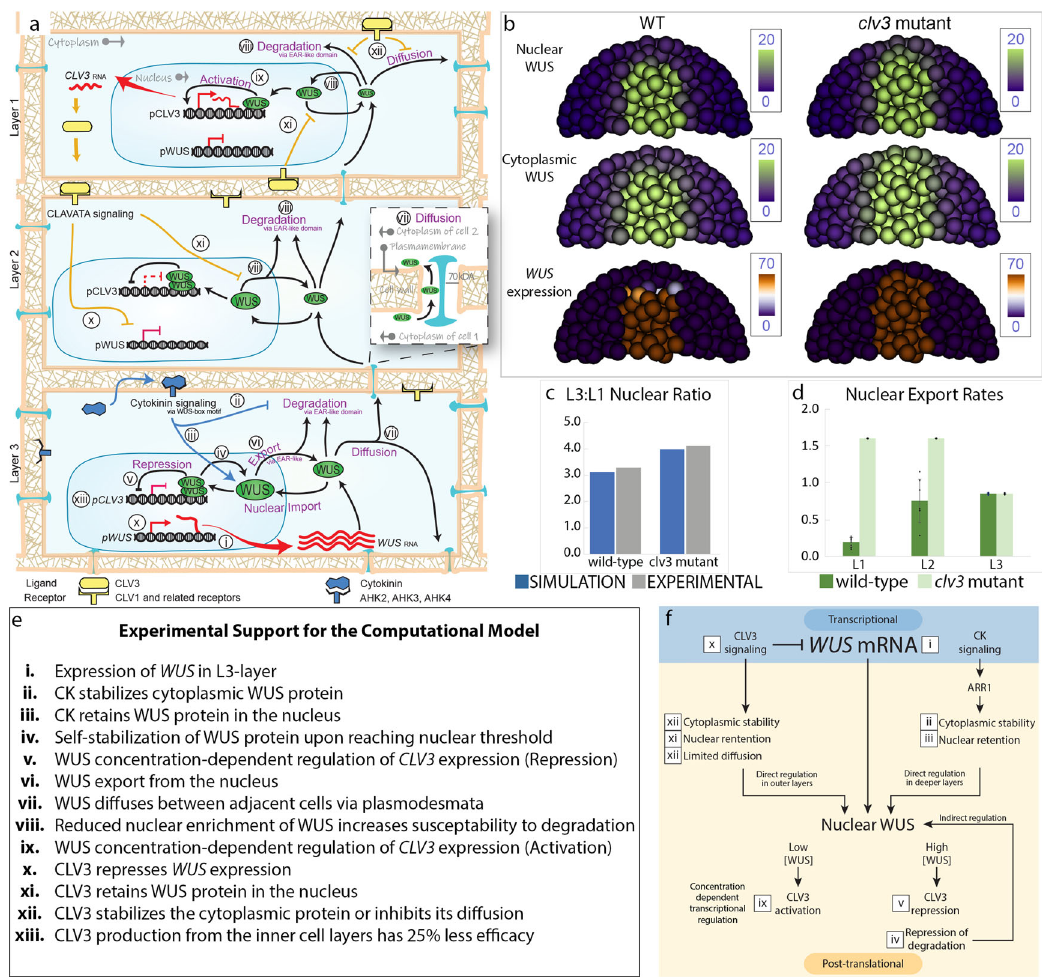
Fig. 5 Multi-cell layer model for the regulation of the WUS protein gradient. a The WUS-CLV3 feedback loop model with WUS-mediated concentration- dependent regulation of CLV3 and CLV3-mediated dual transcriptional and post-translational regulation of WUS. b Model simulation of nuclear WUS protein, cytoplasmic WUS protein, and WUS expression in wild type and clv3-2 mutant SAMs. c Ratio of L3 to L1 (L3:L1) nuclear WUS (mean ± s.d.) for wild type and clv3-2 mutants. For experimental quanti fi cation independently imaged wild type ( n = 7) and clv3-2 ( n = 8) SAMs were considered. For simulations “ n ” represents the number of cells in wild-type L1 [ n = 8] and L3 [ n = 6], and in clv3-2 L1 [ n = 8] and L3 [ n = 6]). d Model prediction of nuclear export rates across cell layers (L1 [ n = 8], L2 [ n = 7], and L3 [ n = 6], mean ± s.d.) of wild type and clv3-2 mutants. The “ n ” represents the number of cells considered for quanti fi cation. e Transcriptional and post-translational experimental support in the computational model. f Simpli fi ed model of transcriptional and post-translational regulation of